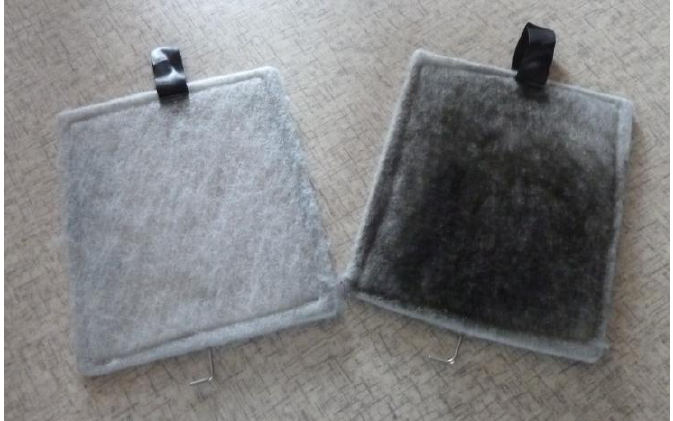
Figure 6. Mechanical Ventilation with Heat Recovery (MVHR) filters, dirt accumulation between scenarios.